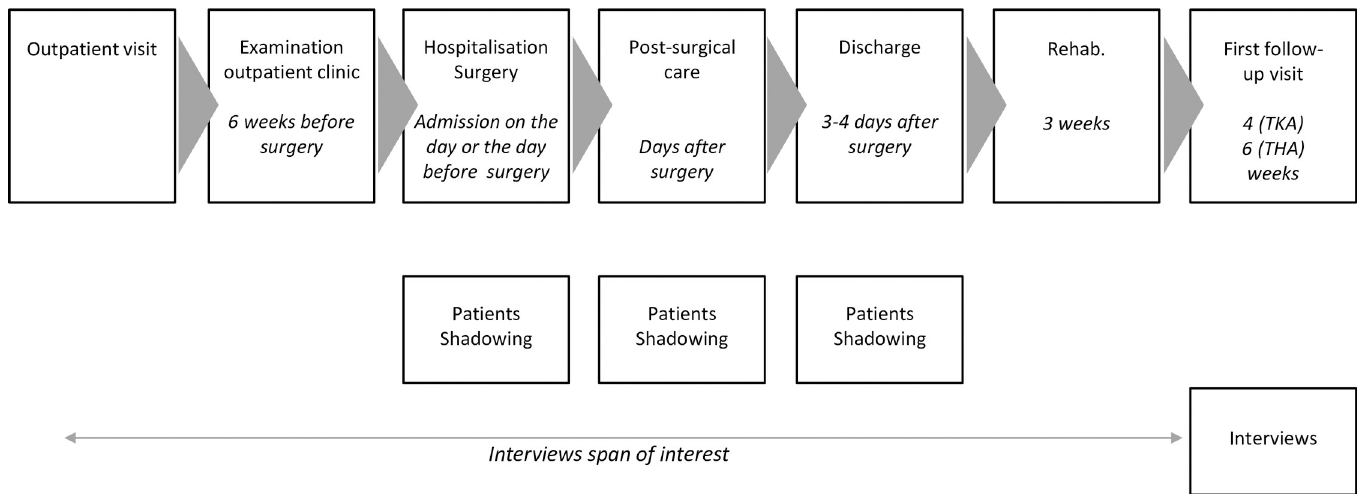
Fig 1. Flow of patients’ pathways in total hip arthroplasty (THA) / total knee arthroplasty (TKA) programme and scheduled timing of the study.